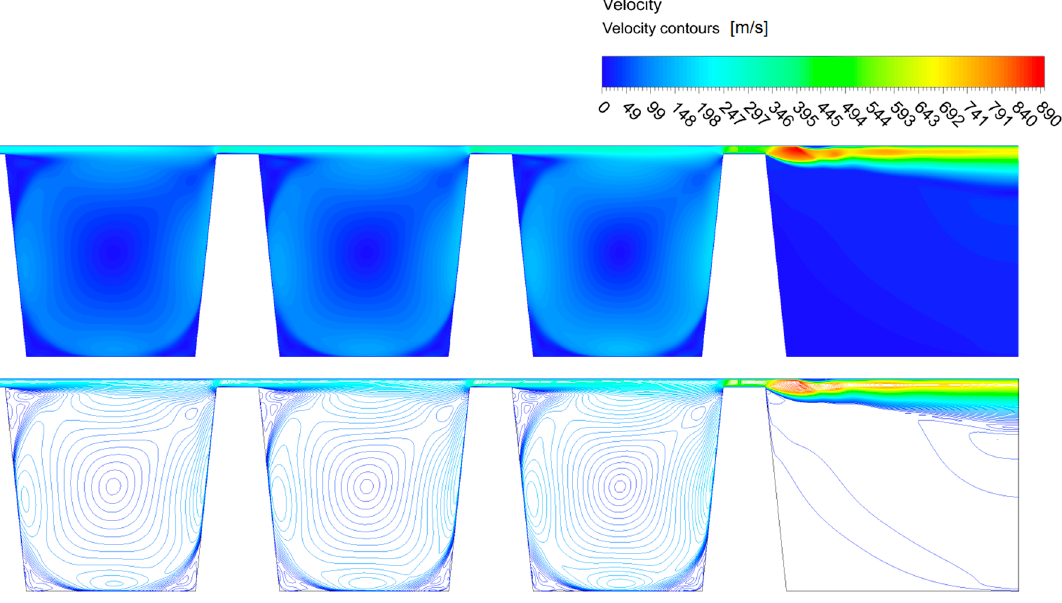
Figure 9. Velocity contours inside the one-sided straight labyrinth